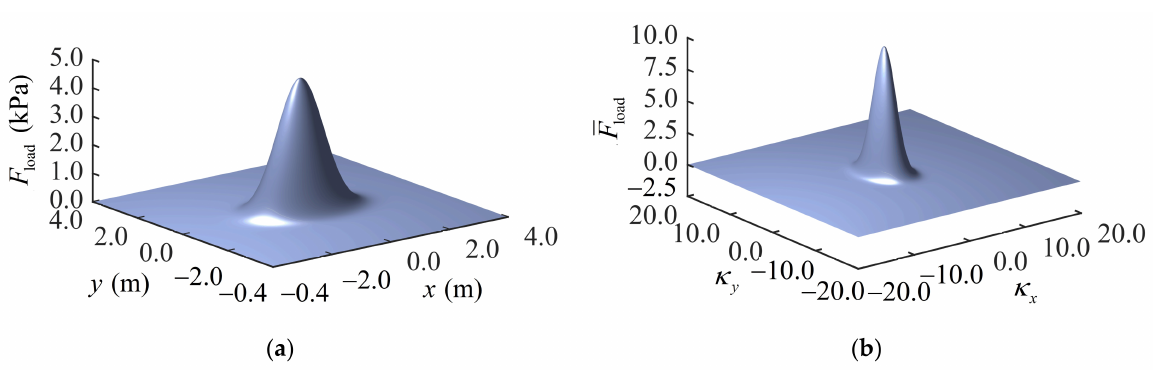
Figure 4. Uniform rectangular load: ( a ) load distribution function, ( b ) Fourier transform.